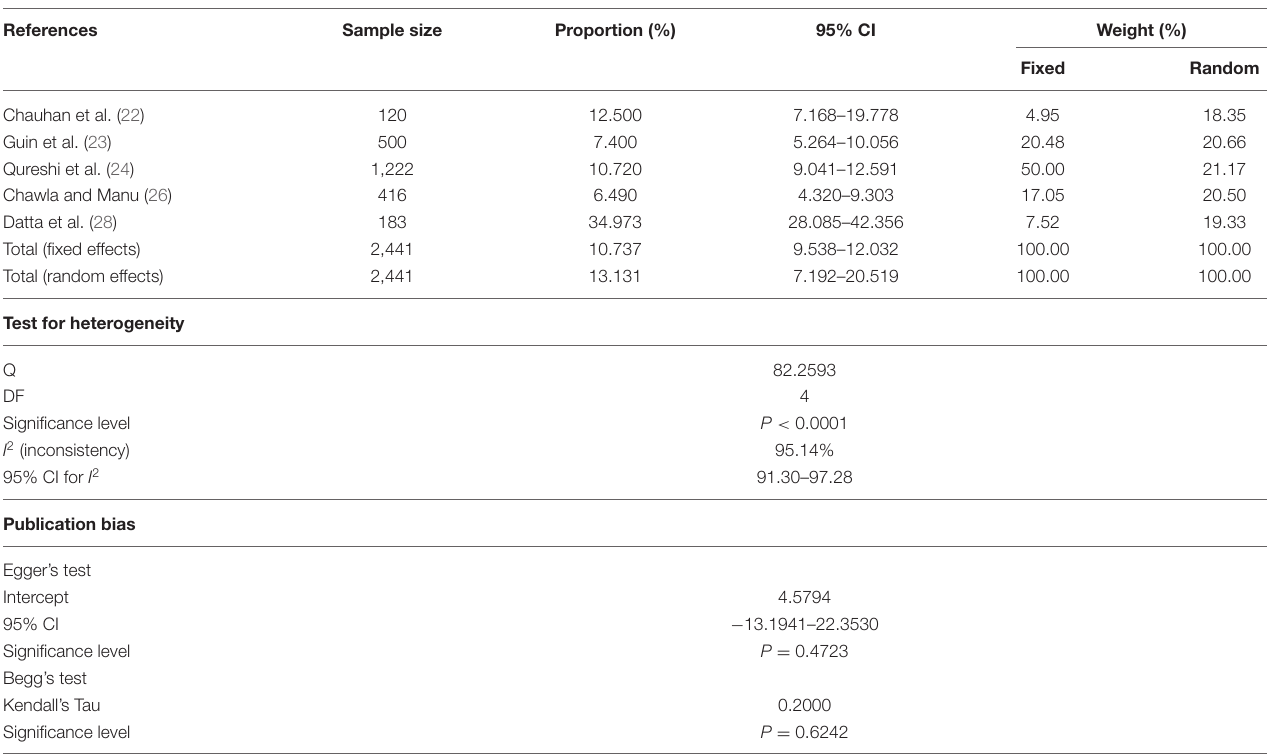
TABLE 7 | Pooled prevalence analysis of malaria in symptomatic pregnant